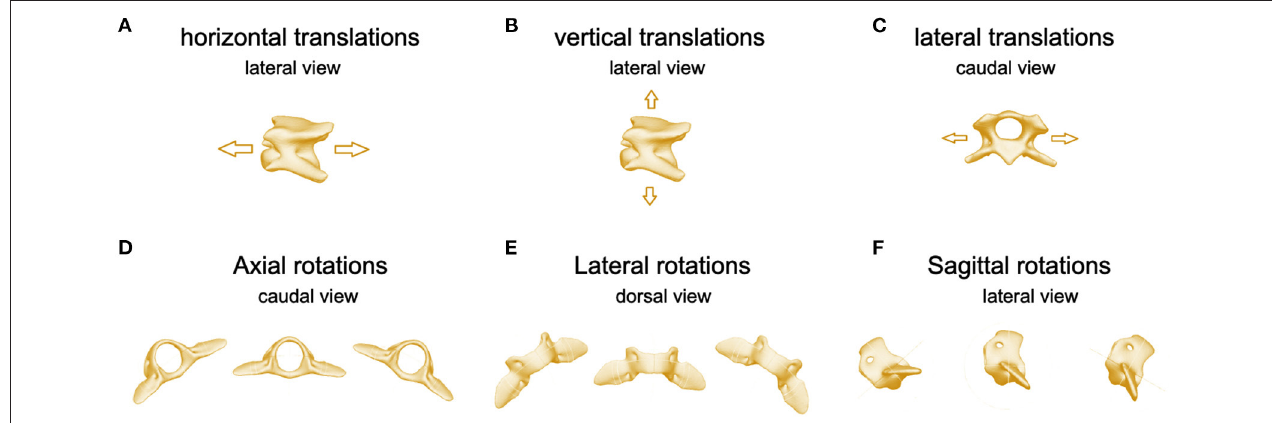
FIGURE 4 | Images of C3 illustrating (A) horizontal translations, lateral perspective, (B) vertical translations, lateral perspective, (C) lateral translations, cranial perspective. Images of C2 illustrating (D) axial, (E) lateral, and (F) sagittal rotations.